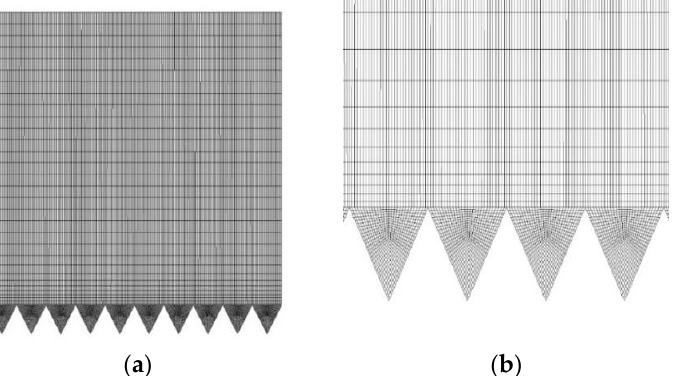
Figure 5. The meshing of the triangular groove plate. ( a ) triangular grooves compute grids; ( b ) tri- angular groove internal grids.